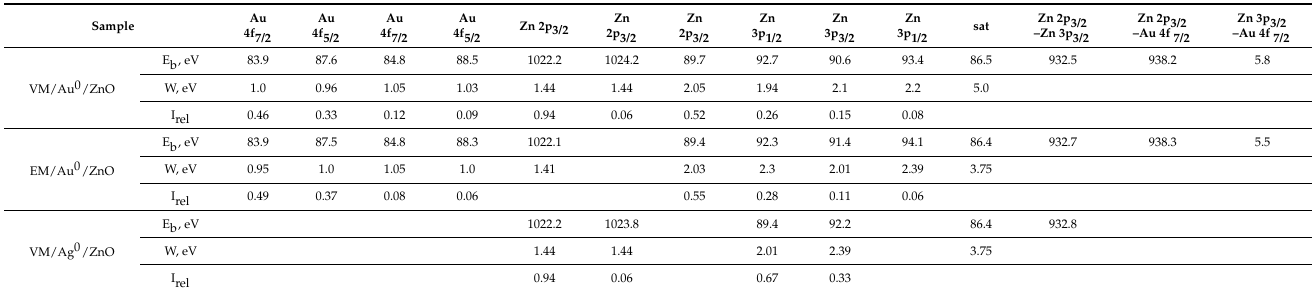
Table 2. Characteristics of the Au 4f, Zn 2p, and Zn 3p photoelectron spectra: binding energies (Eb), Gaussian widths (W), and relative intensities (Irel) of photoelectron peaks belonging to different chemical groups in the C 1s and N 1s spectra.